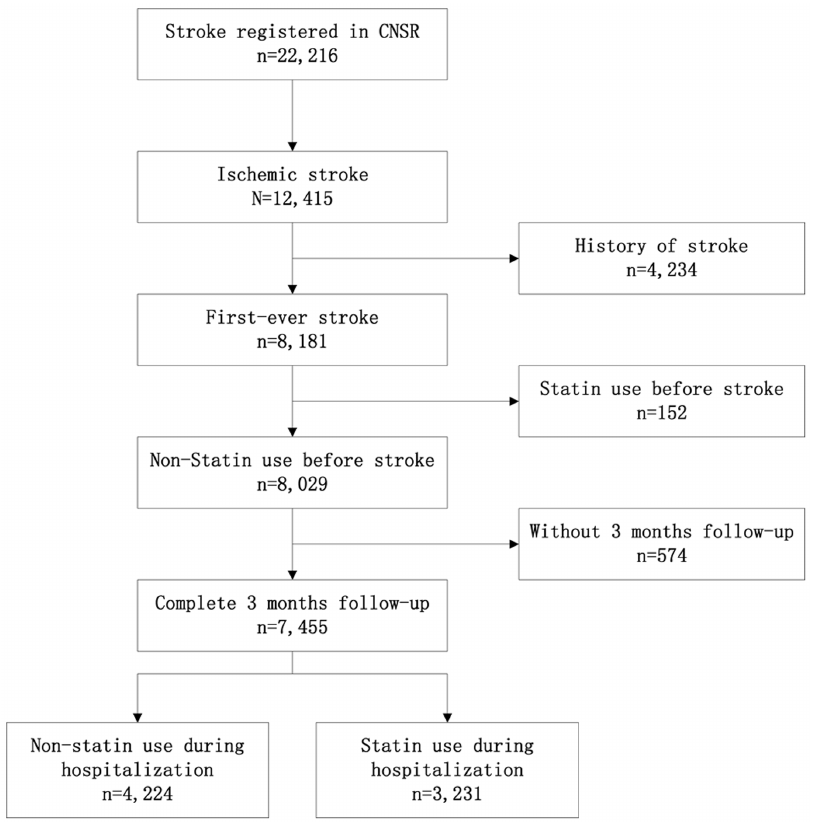
Figure 1. Flow diagram defining the potentially eligible patients with acute stroke for statins treatment.